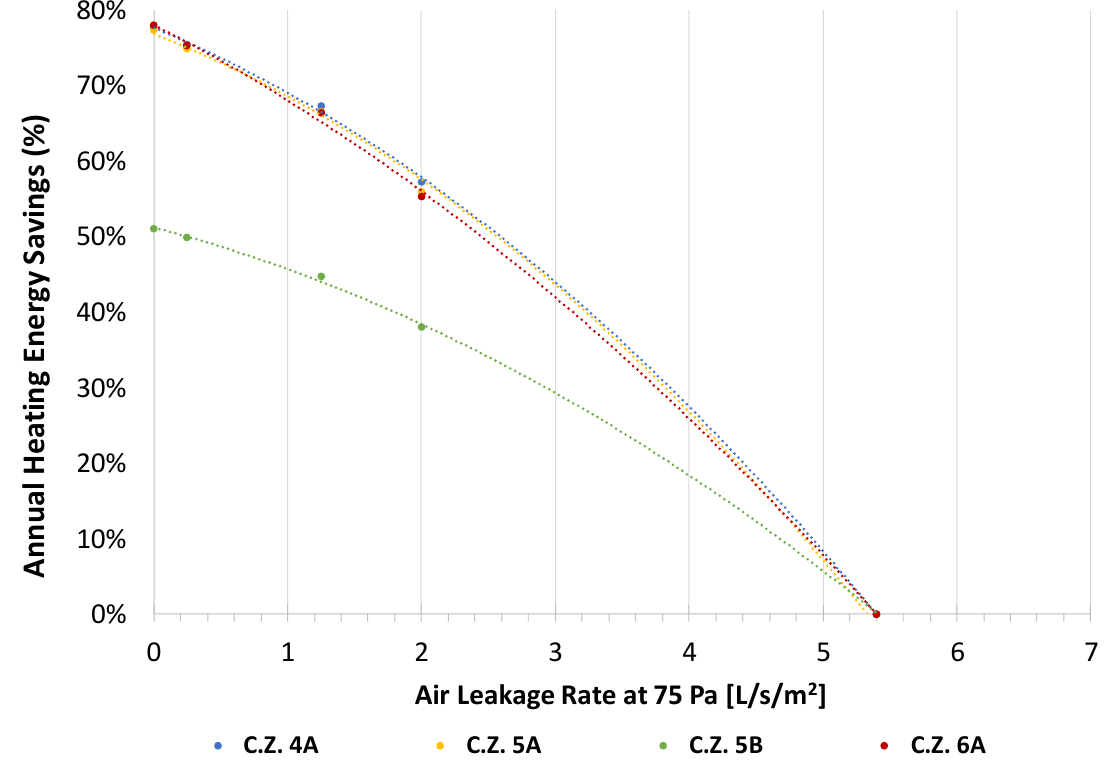
Figure 7. Results from models that calculate the annual relative heating energy savings with increased airtightness in stand-alone retail prototype buildings in climate zones 4A, 5A, 5B, and 6B using Equation (1) and constant values in Table 3.